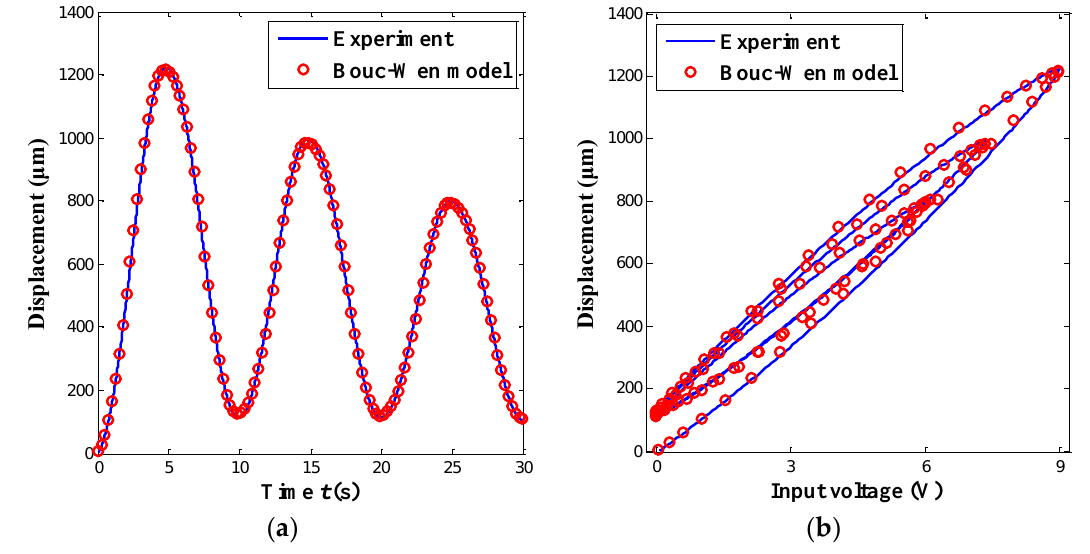
Figure 7. Experimental result of gripping range by applying a multi-amplitude signal: ( a ) time history results; and ( b ) hysteresis loops.